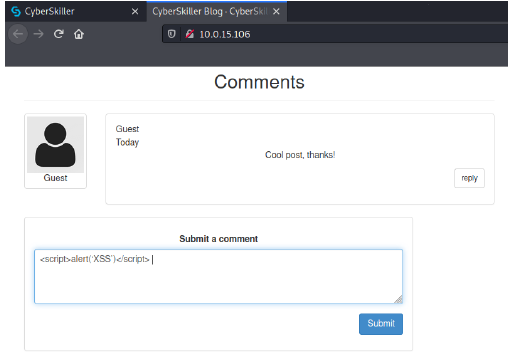
Figure 5. Exercise 5.1: Stored XSS Vulnerability (⋆)